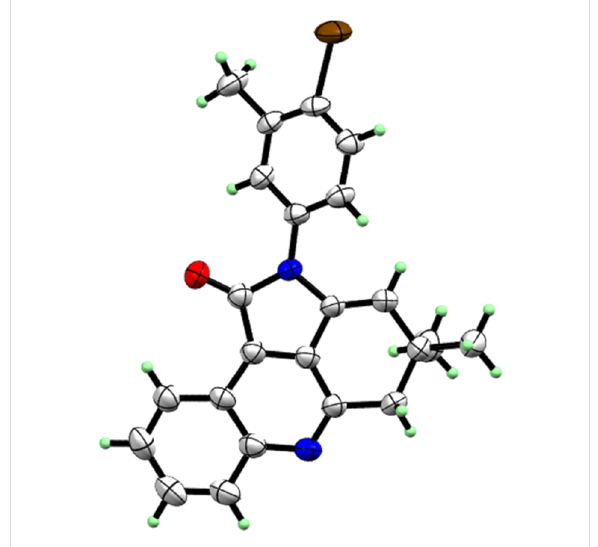
Figure 5: X-ray single crystal structure of 4d (CCDC